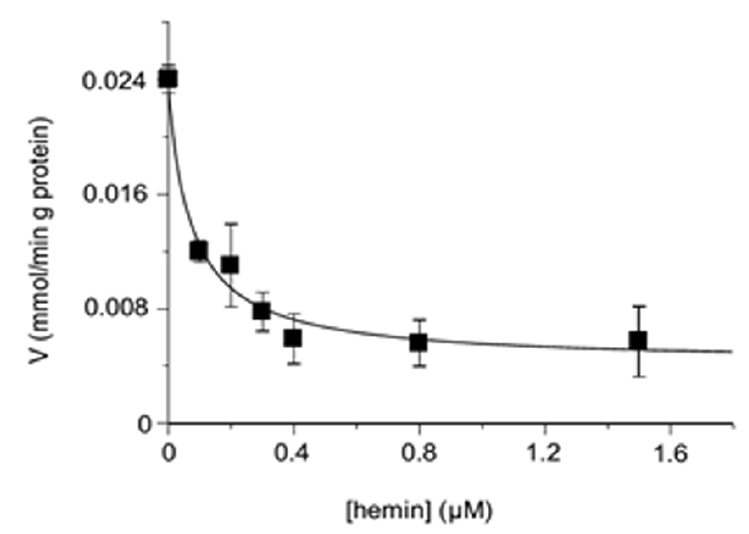
Figure 4. Inhibition of the transport rate of the [ 14 C] malate in the reconstituted OGC carrier by internal hemin. The transport rate of [ 14 C] malate uptake at a concentration of 0.025 mM was measured in 2 min in proteoliposomes containing 6 mM of 2-oxoglutarate, in the presence of internal increasing concentrations of hemin (0–1.5 μM). The values displayed are the means ± SD of three independent experiments (R 2 = 0.986).